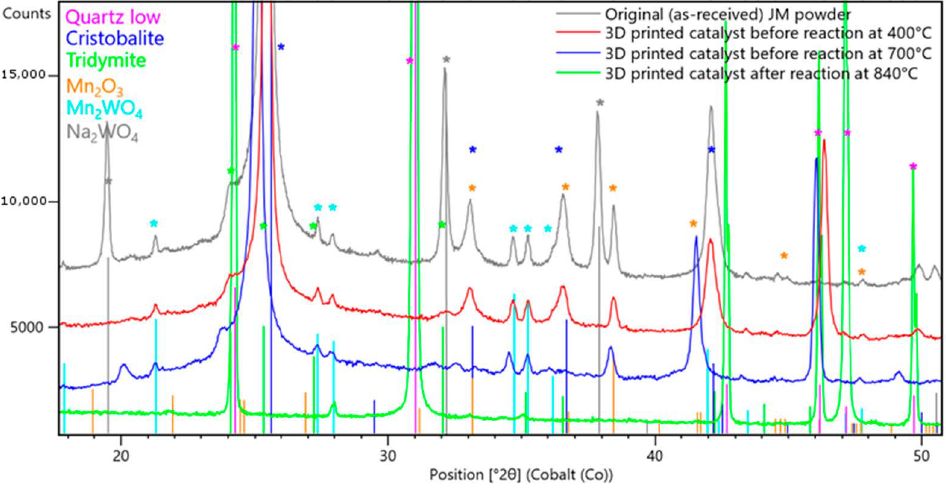
Figure 4. Lab XRD data for 3D printed catalyst calcined at 400 and 700 ◦ C before and after the reaction performed at 840 ◦ compared to the Mn–Na–W/SiO 2 as-received powder (further details on the XRD data and the phases identified at each temperature between 400 and 1000 ◦ C can be found in Figure S2 and Table S1 in the Supplementary Material).